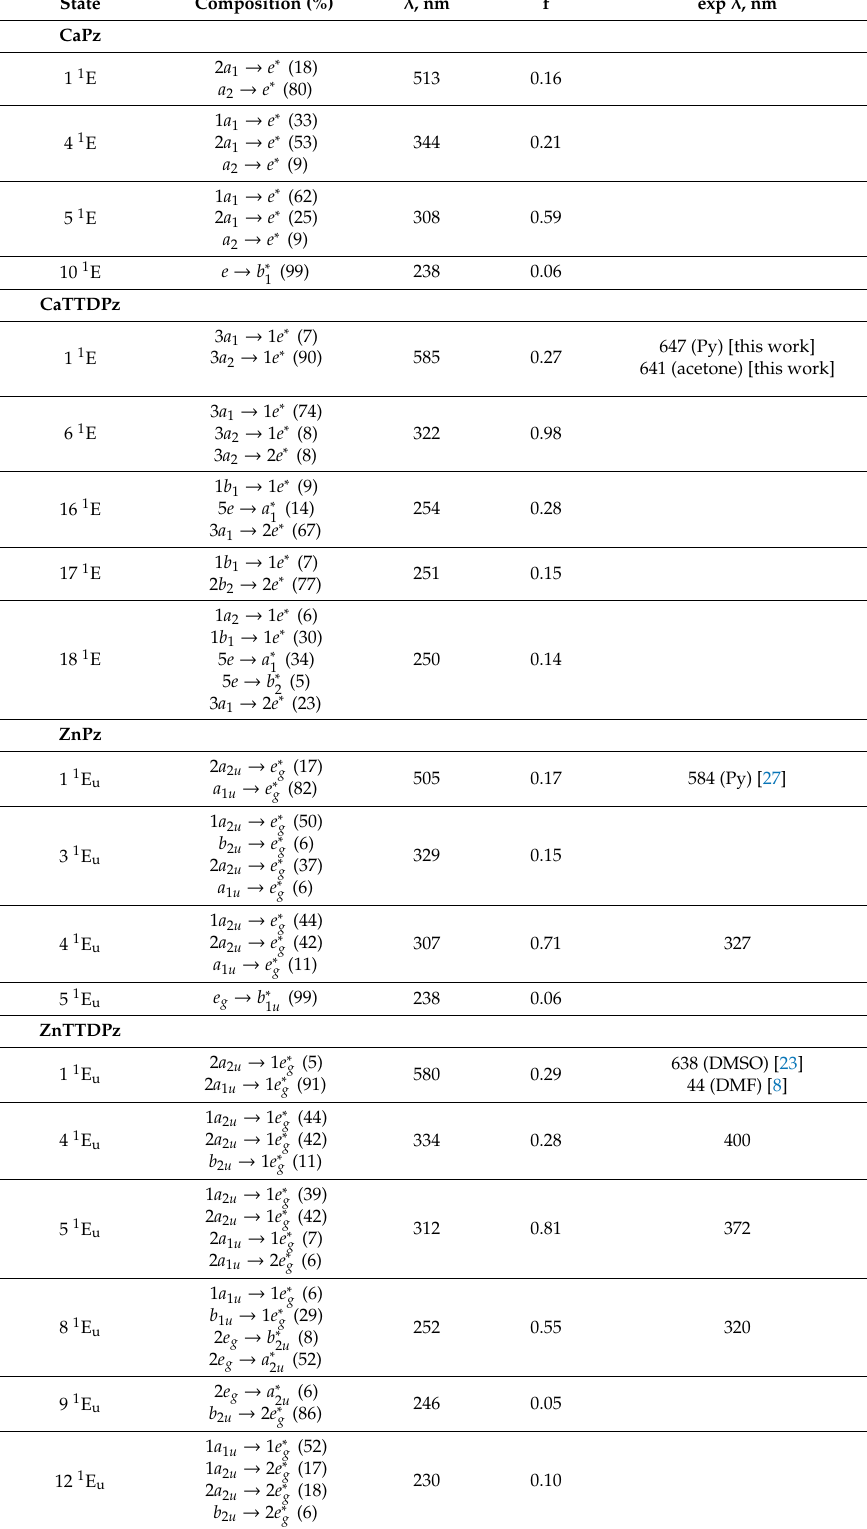
Table 3. Calculated composition of the lowest excited states and corresponding oscillator strengths for MPz and MTTDPz complexes (M = Ca and